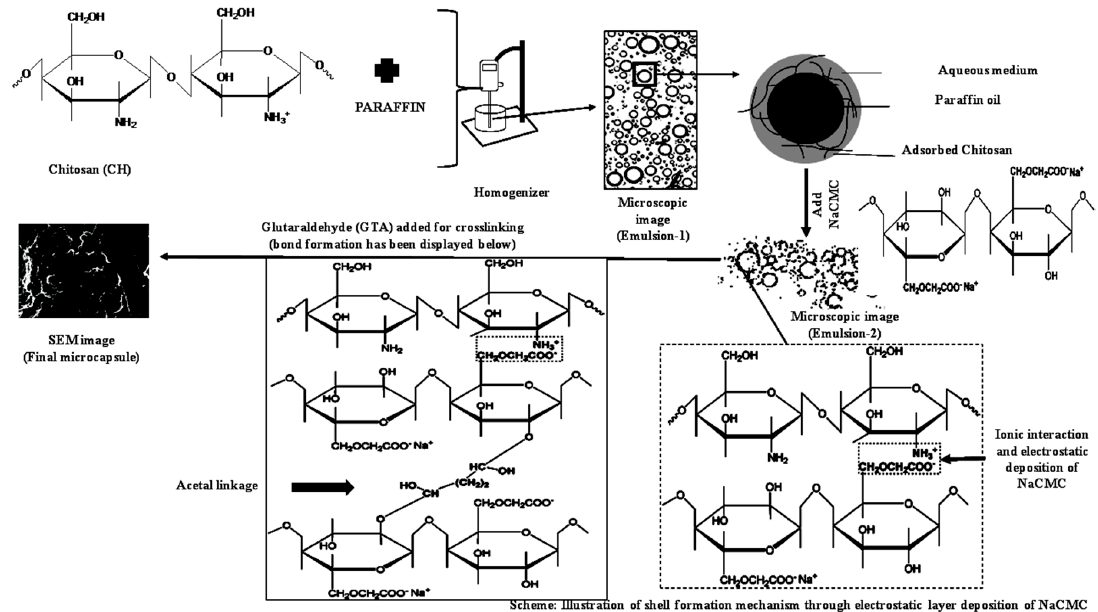
Figure 6. Mechanism of CH–NaCMC complex and crosslinking shell formation.